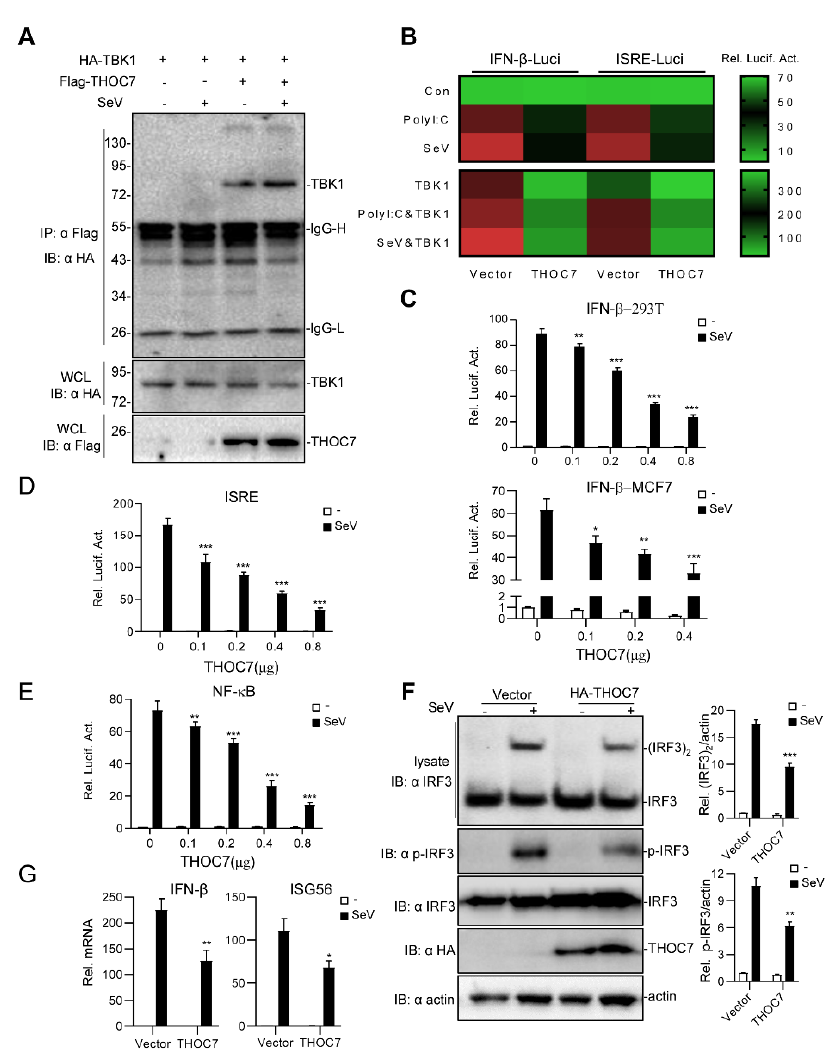
Figure 1. Overexpression of THOC7 negatively regulates the production of type I interferons (IFNs). ( A ) Interaction of THOC7 with TBK1 in a mammalian overexpression system. 293T cells were transfected with mock control, Flag-THOC7, and HA-TBK1 (10 µ g each), followed by treatment with Sev or not for 10 h. At 24 h post-transfection, co-immunoprecipitation was performed with anti-HA beads and immunoblotting analysis with anti-Flag antibodies. ( B ) Small-scale screening of THOC7 functions in regulating SeV- or polyI:C-induced type I IFN signaling. 293T cells were seeded into 24-well plates and transfected with a luciferase reporter gene carrying the ISRE or IFN- β promoter (100 ng/well), pRL-TK (50 ng/well) and THOC7, followed by infection with SeV or transfection with polyI:C/TBK1 for 12 h. Relative luciferase activity levels were arbitrarily set to 0.1 (green). ( C – E ) THOC7 inhibited IFN- β promoter, ISRE, and NF- κ B luciferase activation in a dose-dependent manner. Similar luciferase assay was performed, except with increasing amounts of the expression vector for THOC7. ( F ) THOC7 significantly reduced the phosphorylation and dimerization of IRF3. 293T cells were seeded into 6-well plates and transfected with HA-THOC7 (4 µ g). After transfection for 12 h, the cells were treated with SeV or not for 10 h. Lysates were analyzed by native PAGE or SDS-PAGE. Quantification of western blotting bands from three independent experiments was performed with Image J software. ( G ) THOC7 inhibits IFN- β gene and ISG56 transcription. Similar transfection as described for ( F ) was performed. The mRNA levels were measured by q-PCR. Error bars indicate SD. n = 3. *, p < 0.05; **, p < 0.01; ***, p < 0.001; ns, no significant